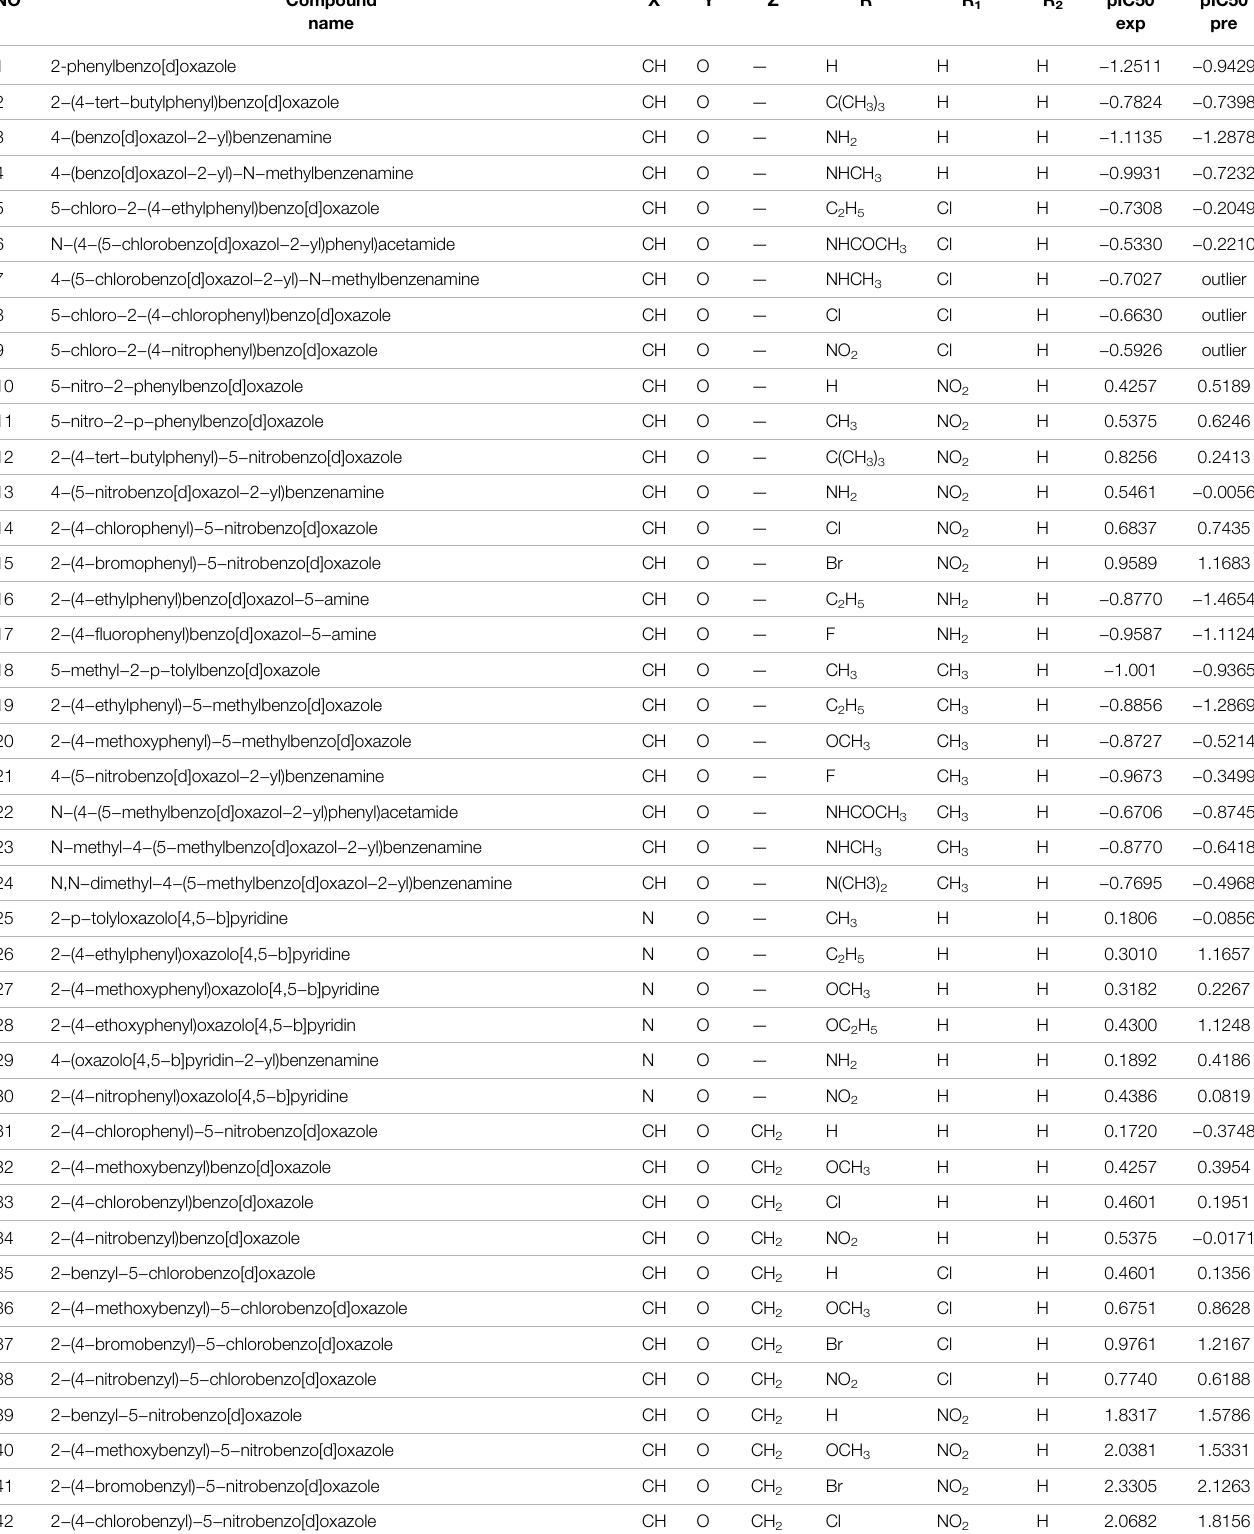
TABLE 1 | Chemical structure, experimental activity and predicted activities of the Candida albicans